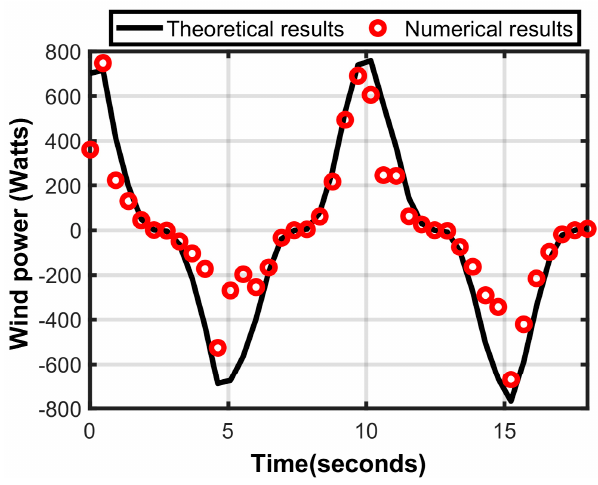
Figure 6. Wind power results.